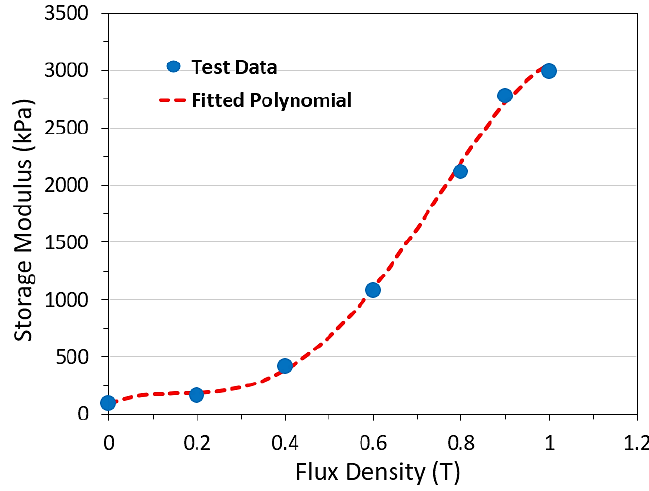
Figure 4. Storage modulus in terms of flux density for the selected MRE sample.